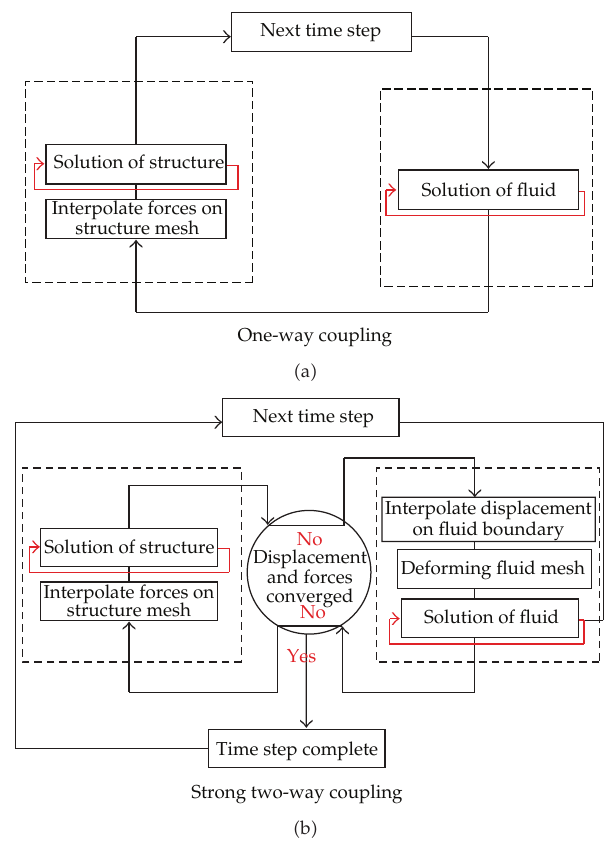
Figure 1: Solution algorithm for one- and strong two-way